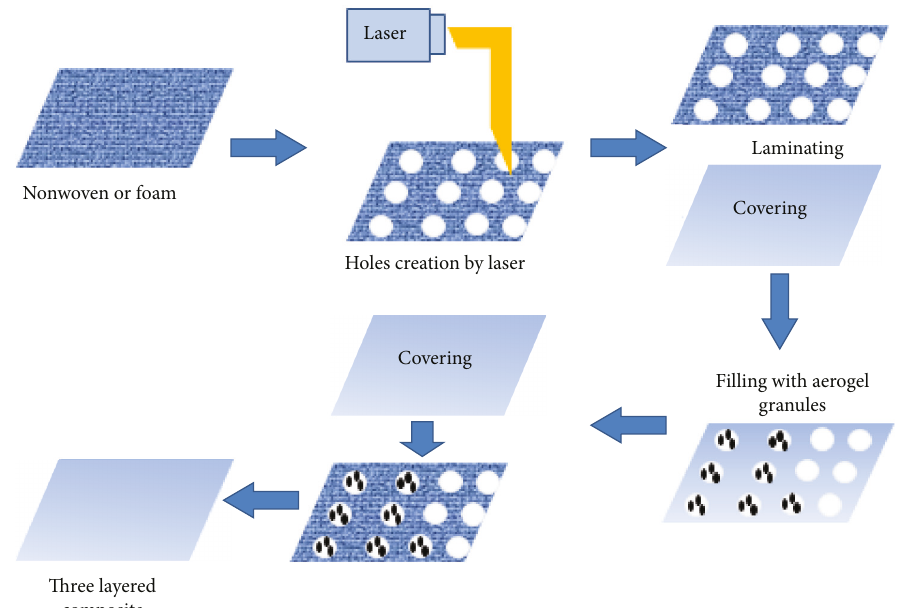
Figure 12: Schematic diagram of the three-layered aerogel nonwoven composite.